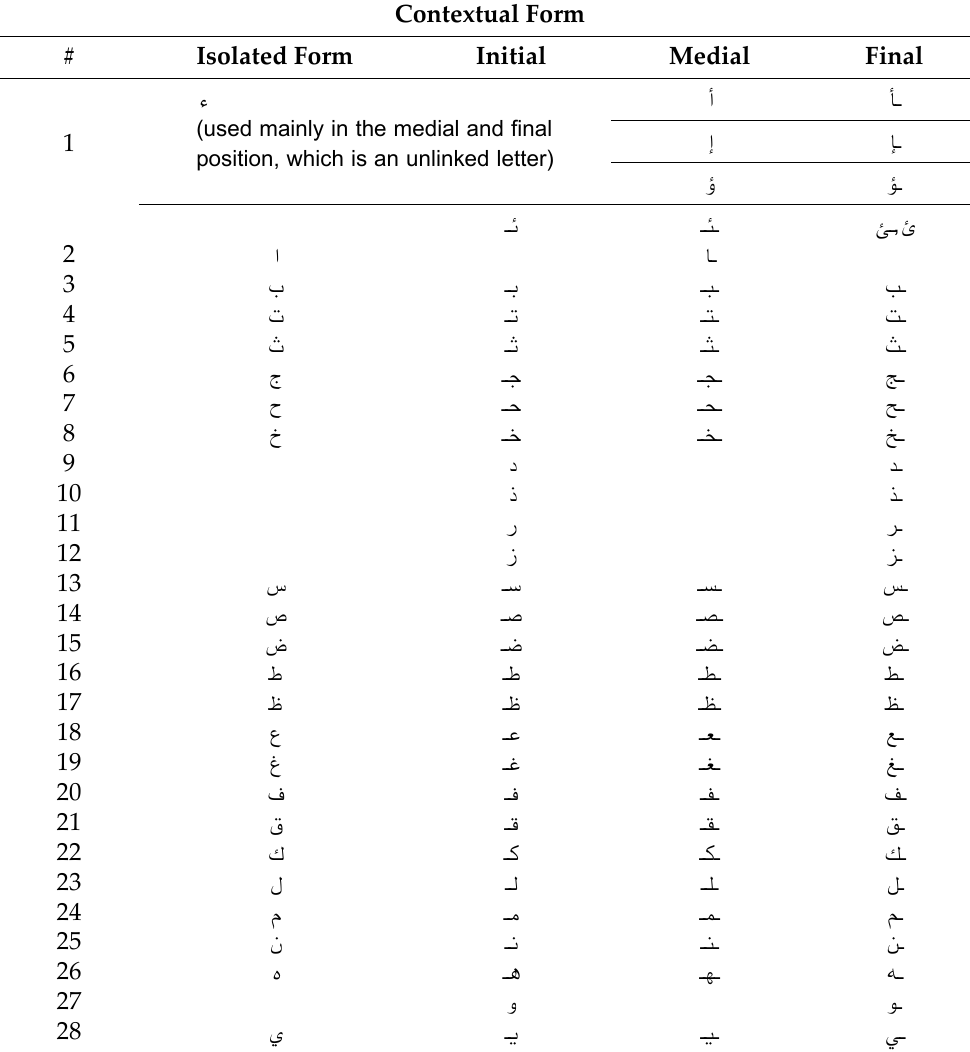
Table 3. Arabic alphabet.